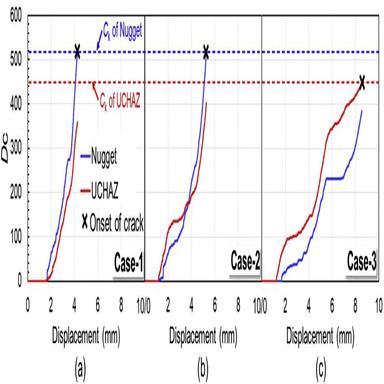
Calculated damage accumulation Dc for nugget and UCHAZ as functions of the applied displacement during the cross-tension test. (a) Case-1, (b) Case-2, (c) Case-3.